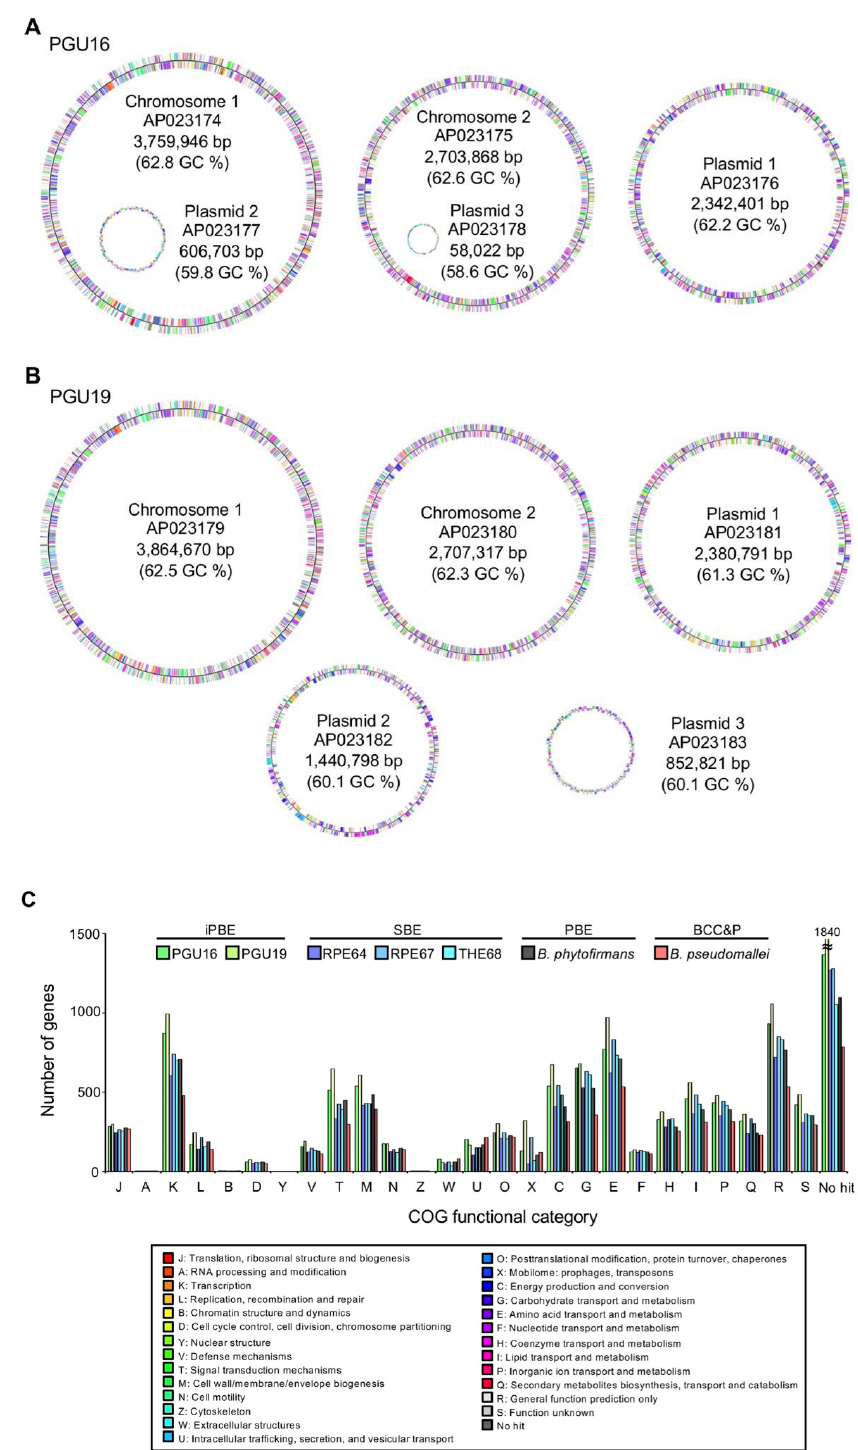
Figure 3. Complete genomes of the isolated iPBE Burkholderia symbionts. Circular visualization of the genomes of Burkholderia sp. strain PGU16 ( A ) and Burkholderia sp. strain PGU19 ( B ). Colors indicate the Clusters of Orthologous Group (COG) functional categories of the genes on the genomes. ( C ) The number of genes classified into each COG functional category in the five symbionts of stink bugs, Burkholderia phytofirmans PsJN and B. pseudomallei K96243. A gene may be classified into two or more categories; therefore, the sum of numbers here might be di ff erent from the total number of genes in a genome. The description of each COG category is shown in the bottom. “No hit” indicates no homologous sequence was detected in the COG database with